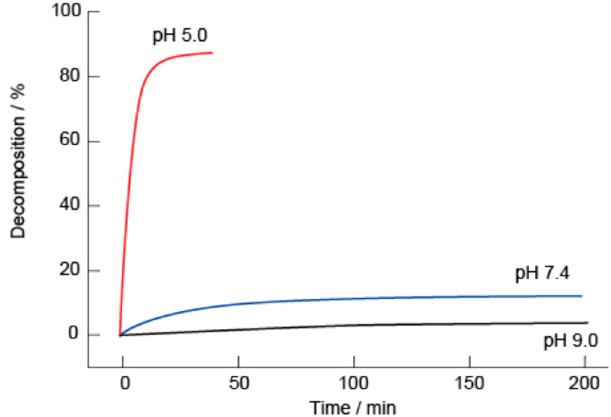
Figure 7. Decomposition kinetics of (SA-PAH/PBA-PAH) 10 films in 10 mM MES (pH 5.0), 10 mM HEPES (pH 7.4) or 10 mM CHES (pH 9.0) buffers. The films were prepared using a 10 mM CHES buffer (pH 9.0). All buffer solutions contained 1 M NaCl.